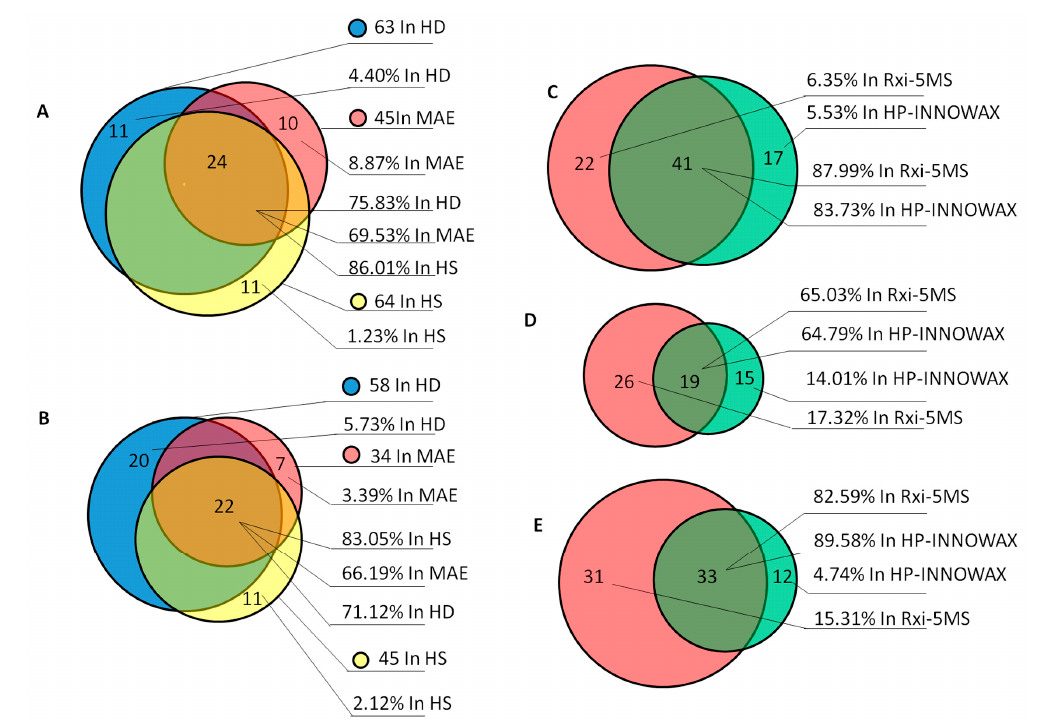
Figure 2. Distribution of compounds identified using two columns (( A ) Rxi-5MS; ( B ) HP-INNOWAX) and three extraction methods (( C ) HD; ( D ) MAE; ( E ) HS).